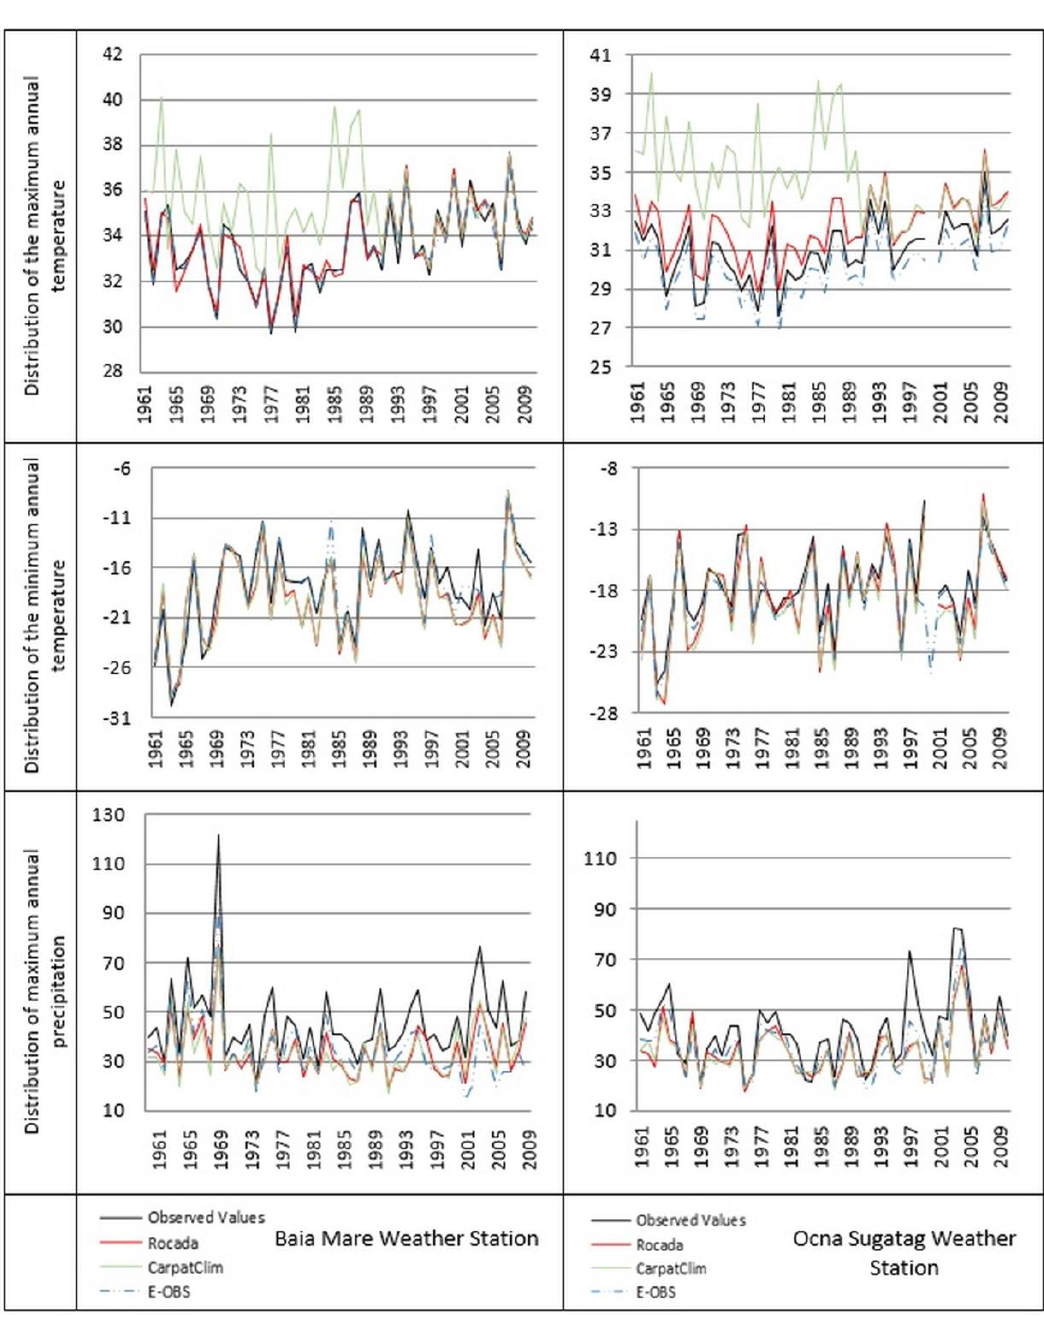
Figure 6. Extreme annual TX, TN, and RR values derived from observation and gridded datasets over the period 1961–2010 at the Baia Mare and Ocna S ugatag weather ,